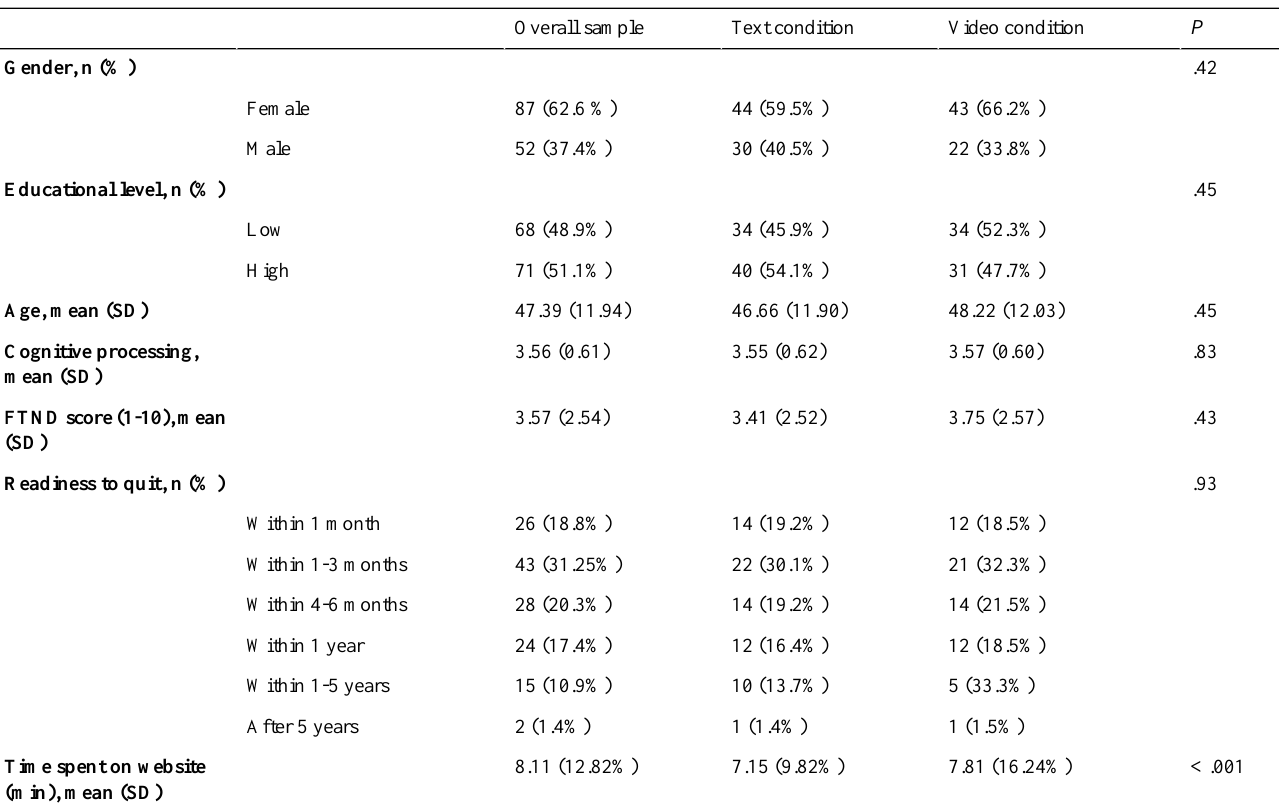
Table 1. Sample characteristics of adult Dutch smokers